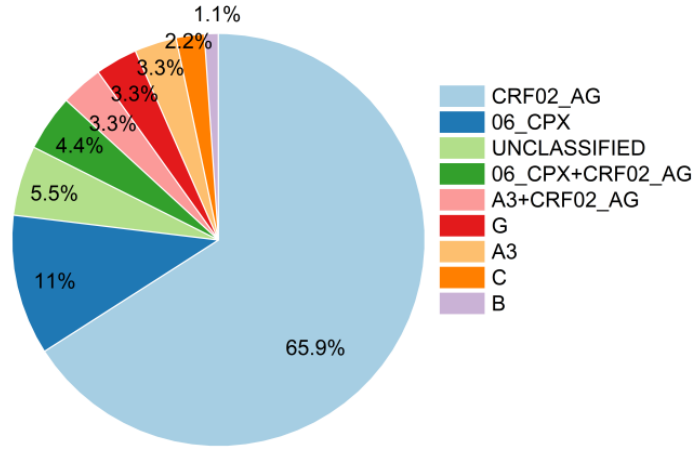
Figure 1. Subtype distribution based on protease-RT sequences